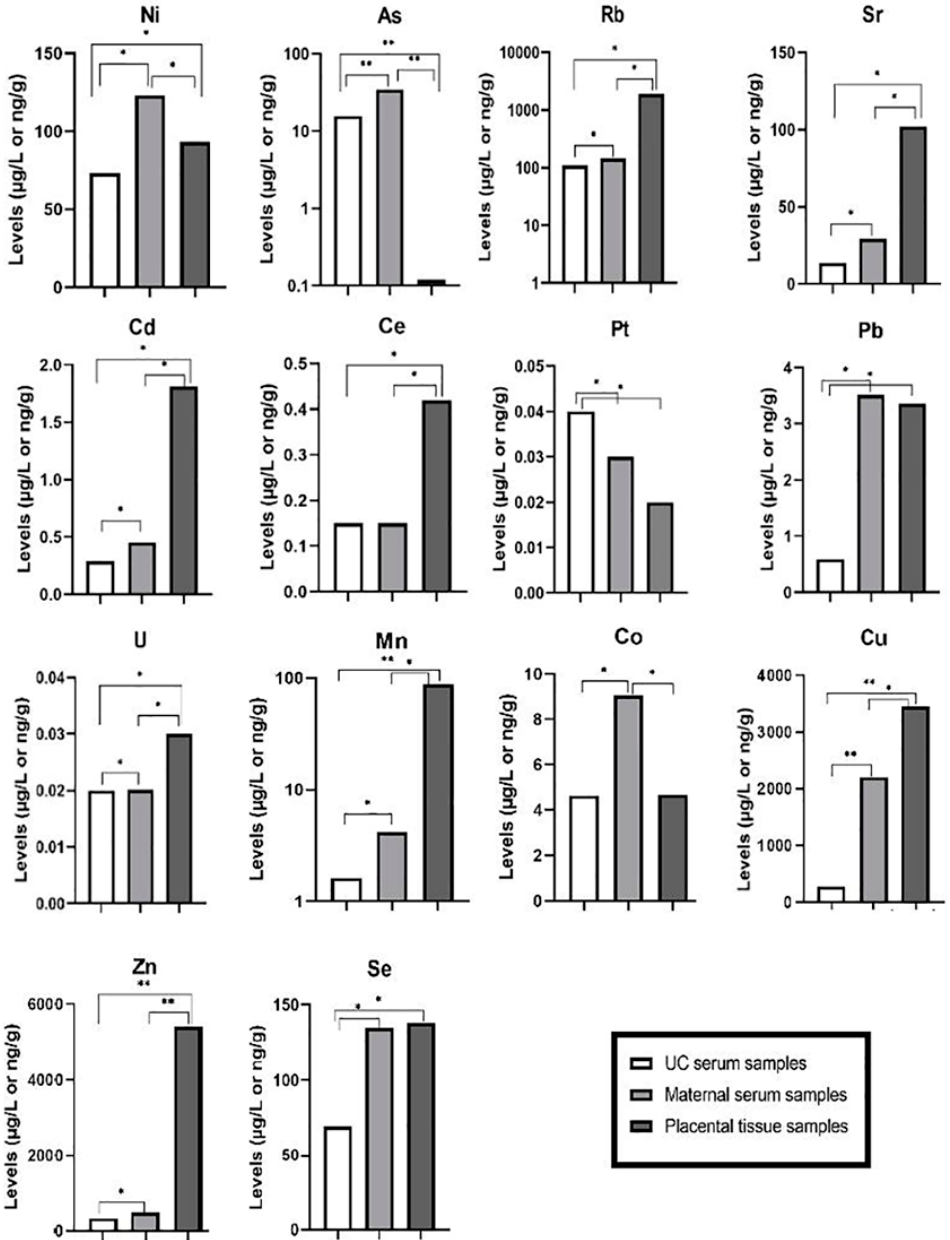
Figure 1. Levels of determined toxic and essential trace metals in UC serum (µg/L), maternal serum (µg/L) and placental tissue samples (ng/g). * p < 0.05; ** p < 0.01.